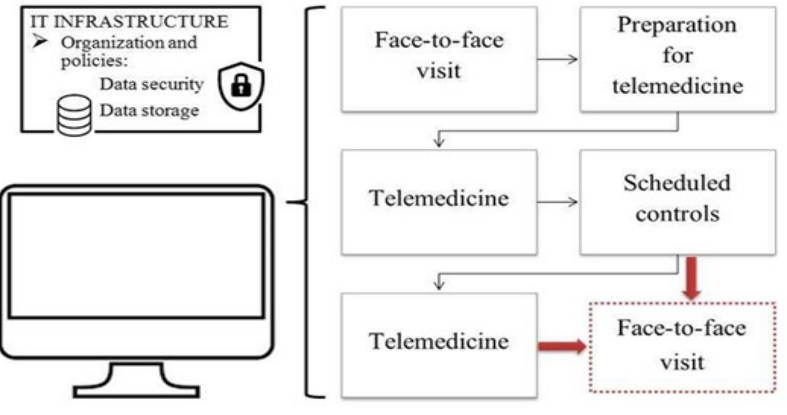
Figure 1. Telemedicine pathway for addressing chronic